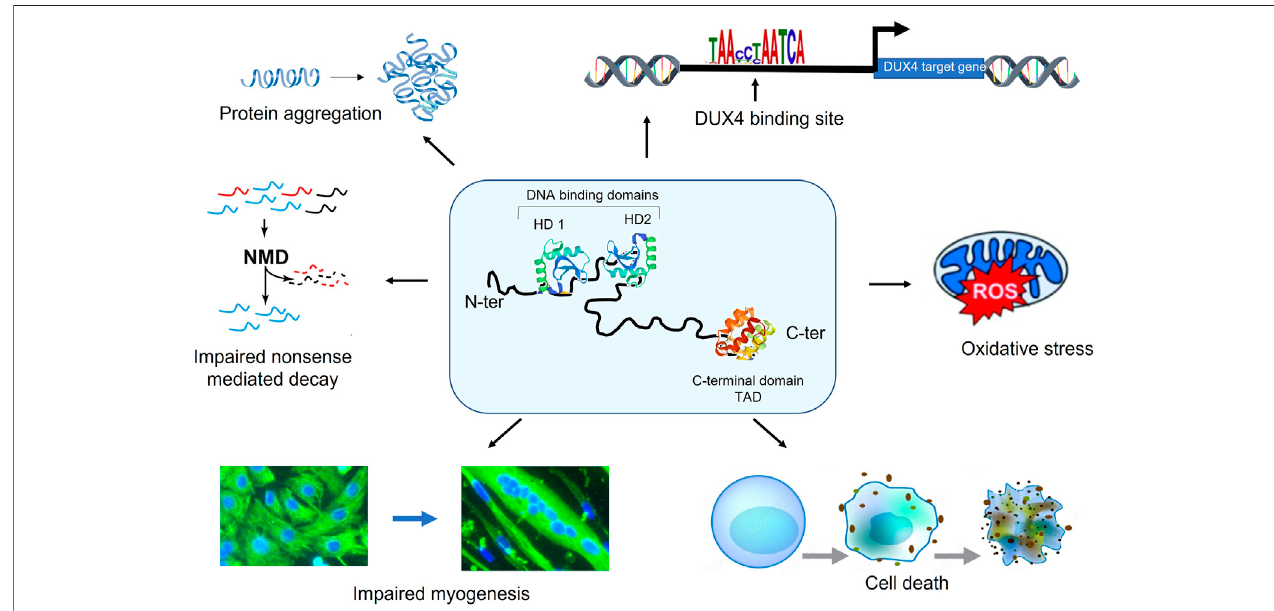
FIGURE 3 | DUX4 is a toxic protein. DUX4 is composed of 2 DNA-binding homeodomains (HD1 and HD2) localized in its N-terminal region. The C-terminal part of the protein includes the transcription transactivation domain (TAD). DUX4 expression perturbs many cellular pathways involved leading to in myo fi ber death, increased sensitivity to oxidative stress, defects in myogenesis, muscle atrophy, inhibition of the non-sense mediated decay and the aberrant expression of hundreds of genes.